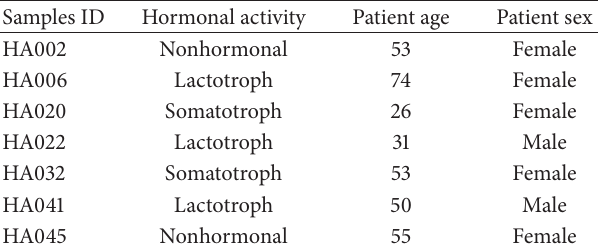
Table 1: Pituitary adenoma samples